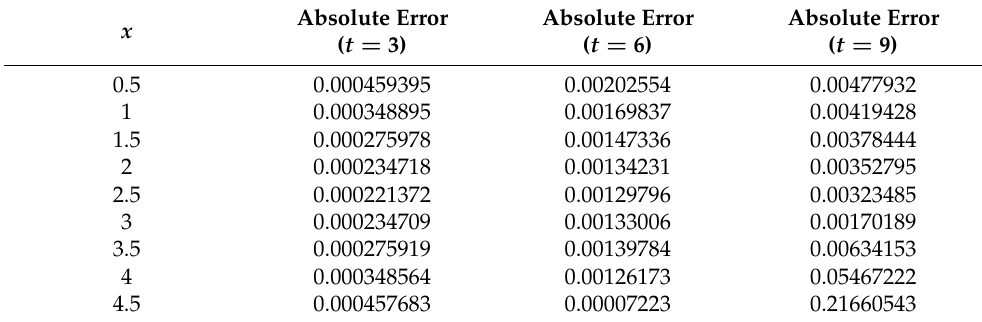
Table 4. The absolute errors for Example 2.